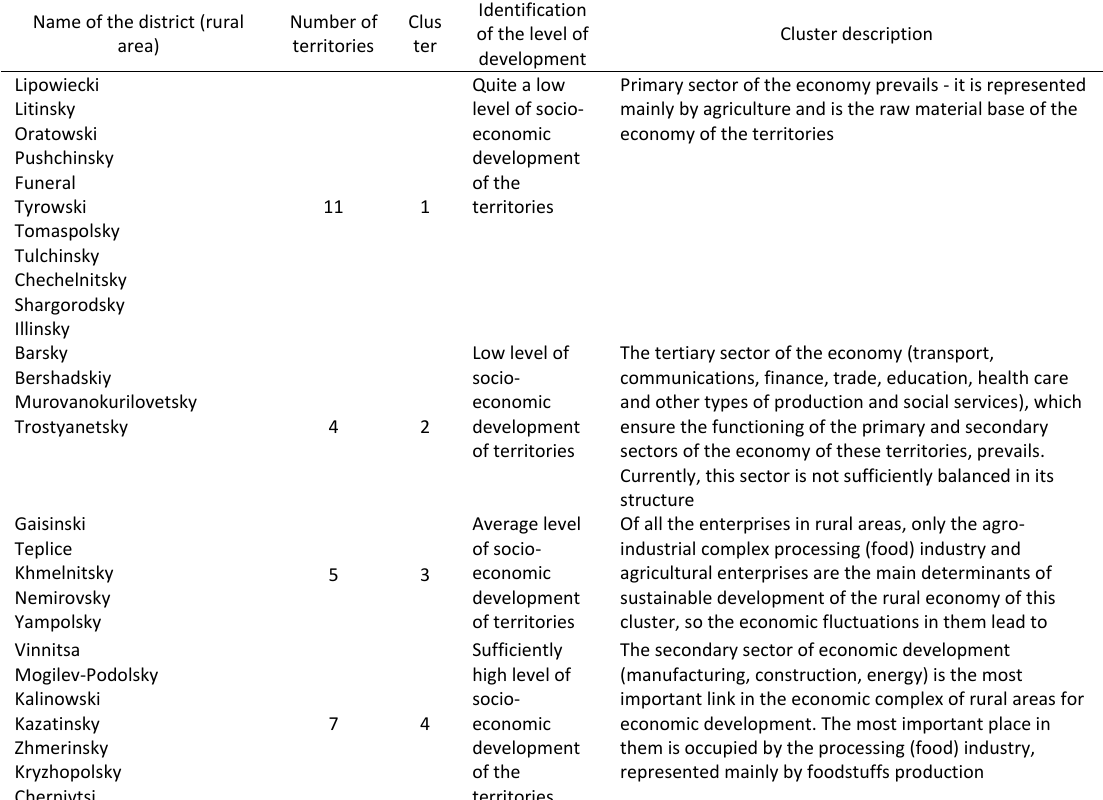
Table 4: Objects (rural areas) that are part of the received clusters Name of the district (rural area)